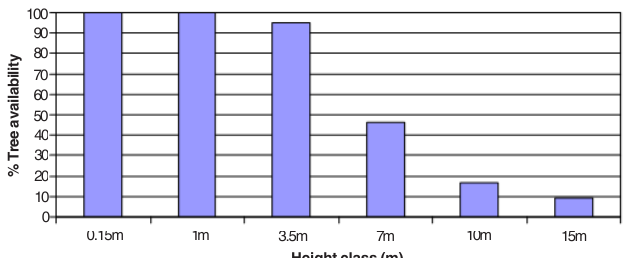
Figure 5. Percent tree availability at different height classes in the Kottawa Arboretum